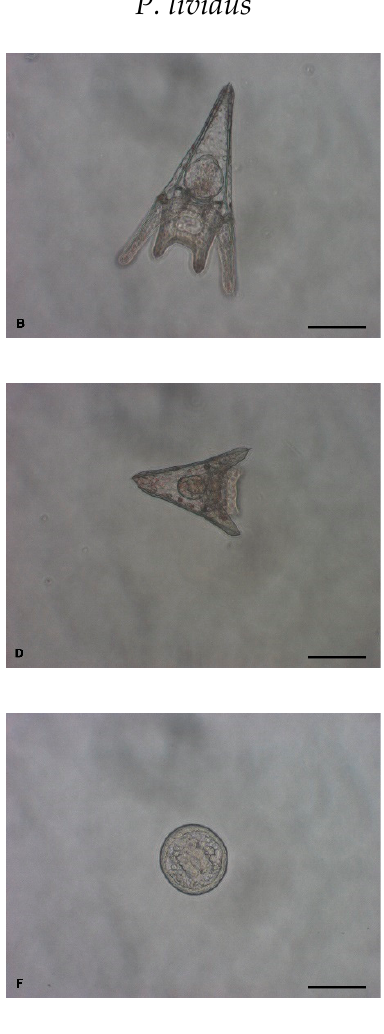
Figure 10. Normal larvae at pluteus stage ( A , B ), developmentally delayed larvae ( C , D ) and undevel- oped embryos ( E , F ) after 48 h exposure to AgNPs (scale bar = 100 µ